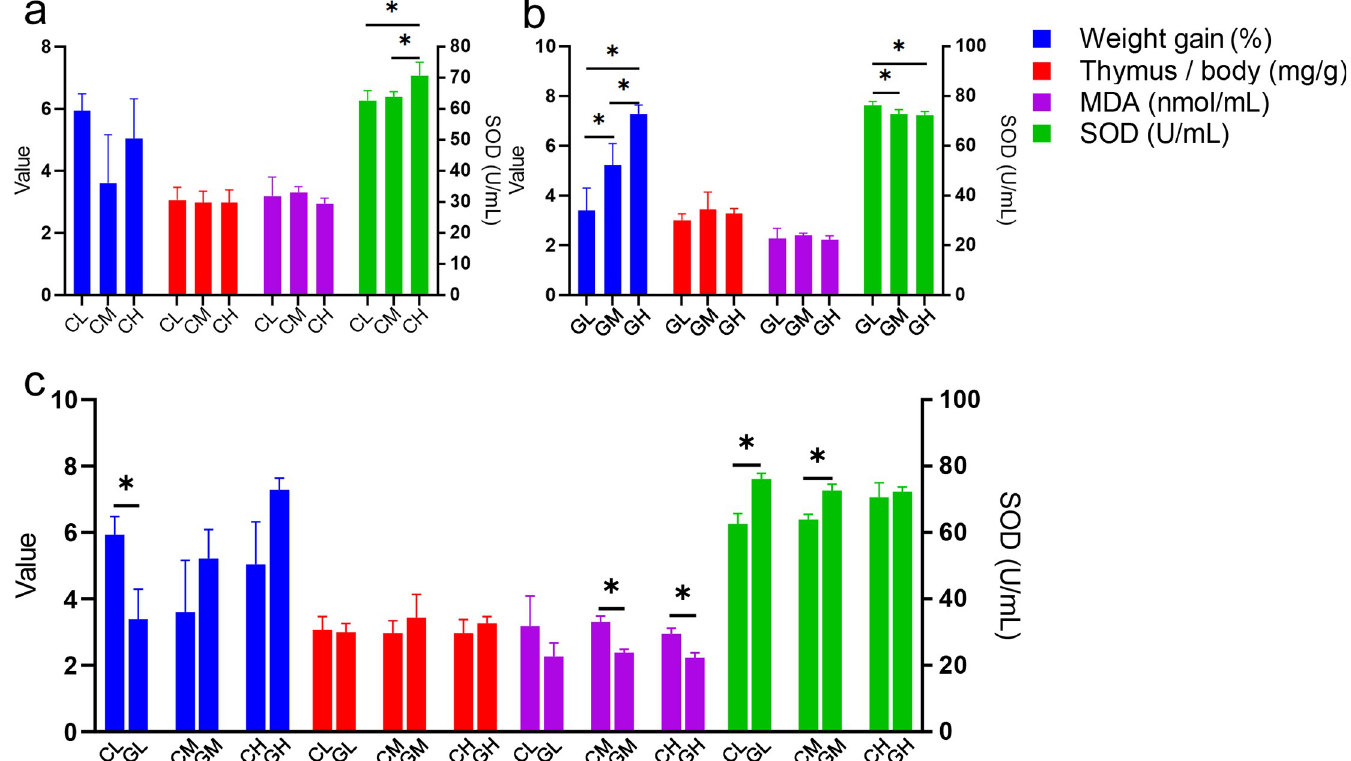
Fig 1. The physiological indexes among different whey protein treated groups. a. physiological indexes in cow whey protein treated groups; b. physiological indexes in goat whey protein treated groups; c. comparisons of different types of whey proteins at the same concentration. � Correlation is significant at the 0.05 level. The left- hand ordinate showed the value of weight gain (%), Thymus/body (mg/g) and MDA content (nmol/mL); The right-hand ordinate showed the SOD activity (U/mL). NC: Normal control; NS: Negative control; Vc: Positive control; CL, CM, CH represents low-, middle-, high-concentration cow whey protein intervention group, respectively. GL, GM, GH represents low-, middle-, high-concentration goat whey protein intervention group, respectively.